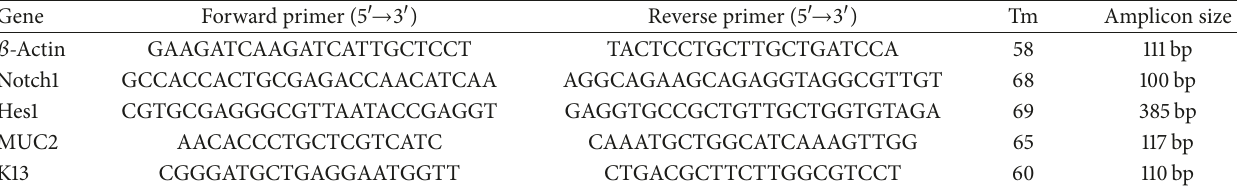
Table 1: The sequences for the primers used for